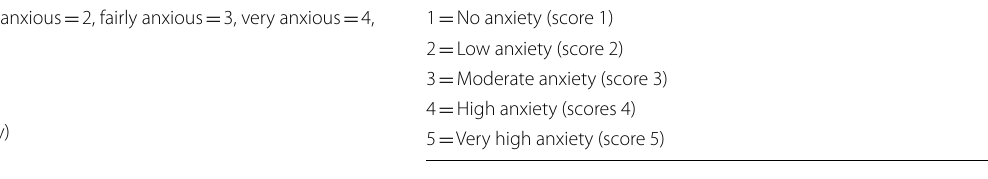
Table 2 Interpretation of MDAS Scores (Humphris et al. 1995) Table 3 Interpretation of FIS scores (Buchanan and Niven Not anxious 1, slightly anxious 2, fairly anxious 3, very anxious 4, = = = = extremely anxious 5 = 0–5 (not anxious)